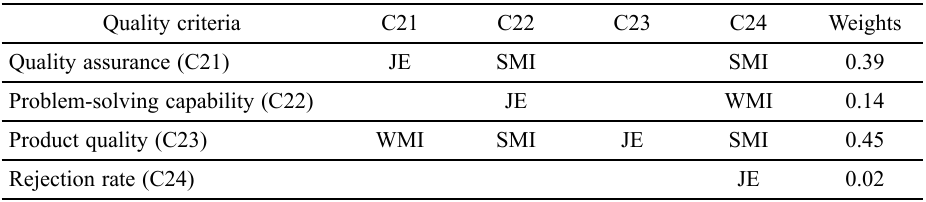
Table 5. Local weights and pairwise comparison matrix of quality (C2) sub-criteria Quality criteria